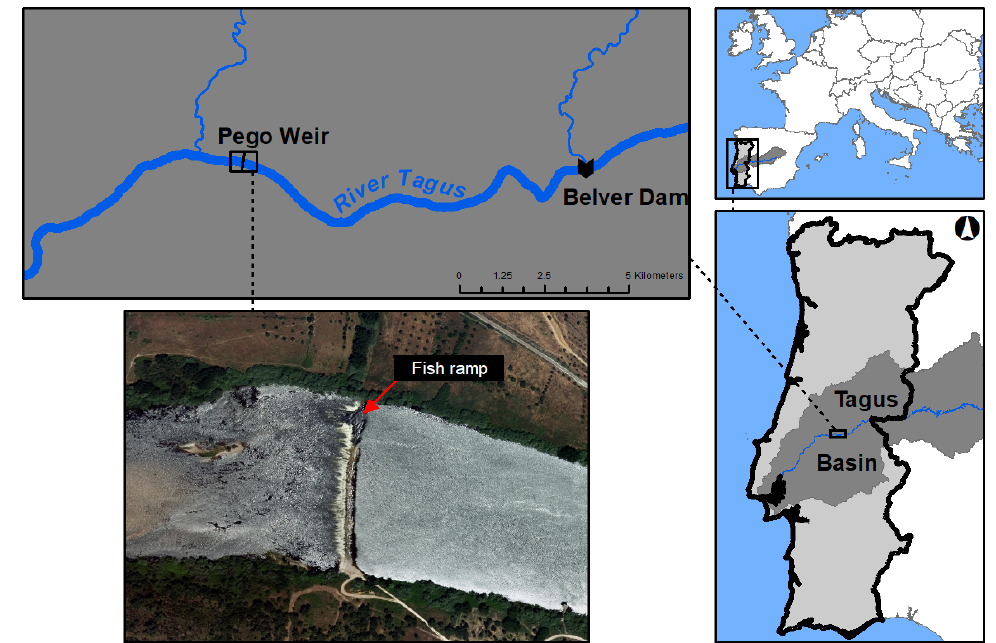
Figure 1. Pego weir in the Tagus River, approximately 12 km downstream of the Belver dam.